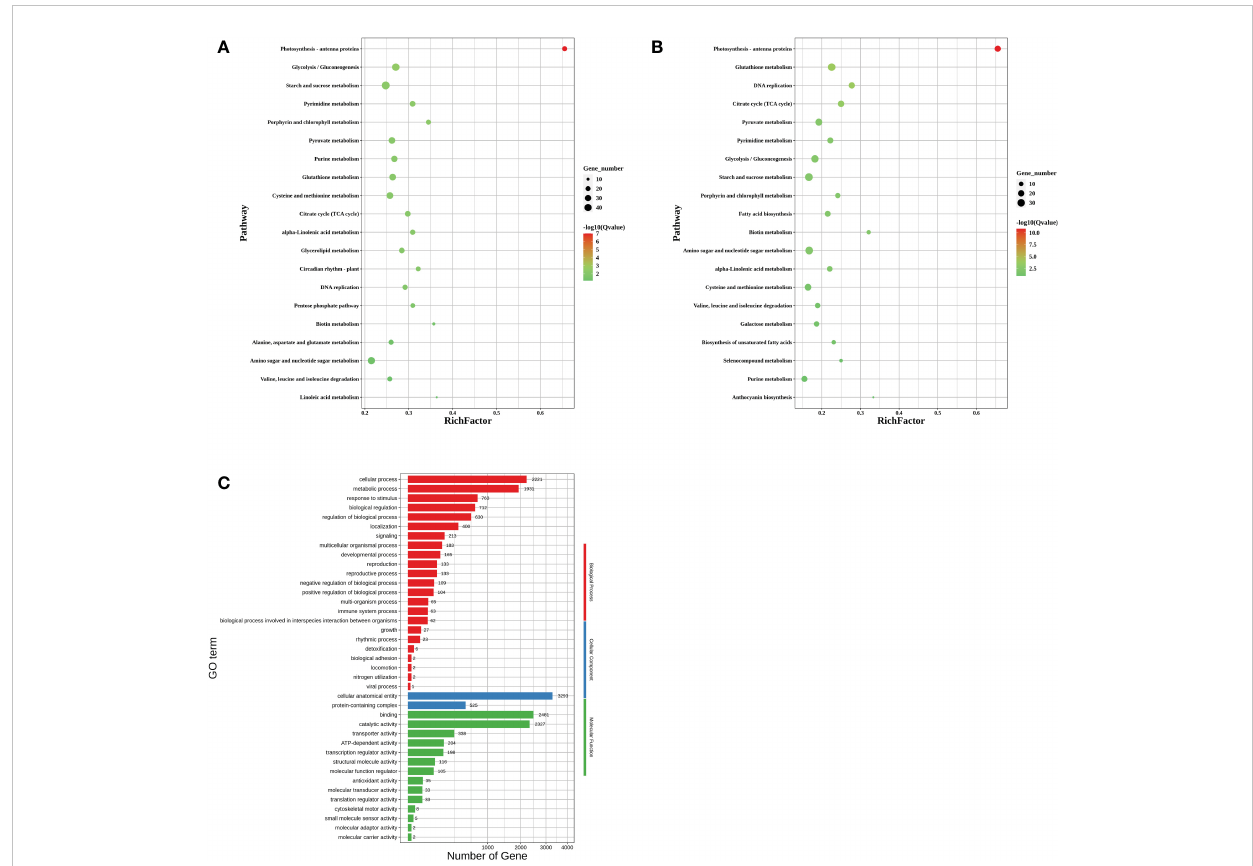
FIGURE 8 RNA-seq analysis of differentially expressed genes (DEGs) in CA10g11690 silenced plants compared with the negative controls. (A) Kyoto Encyclopedia of Genes and Genomes (KEGG) pathway enrichment analysis of DEGs. (B) KEGG pathway enrichment analysis of downloaded DEGs. (C) Gene Ontology (GO) enrichment analysis of